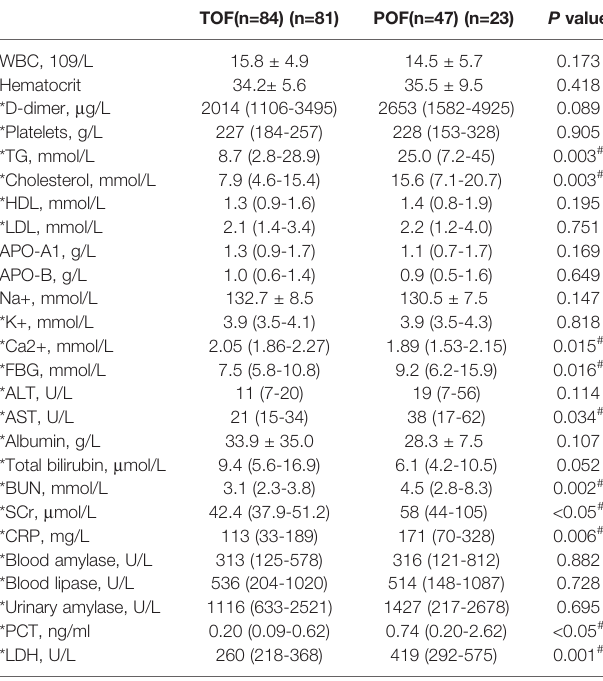
TABLE 4 | Comparison of laboratory parameters between APIP patients in the POF and TOF groups within 24 h of admission. TOF(n=84)